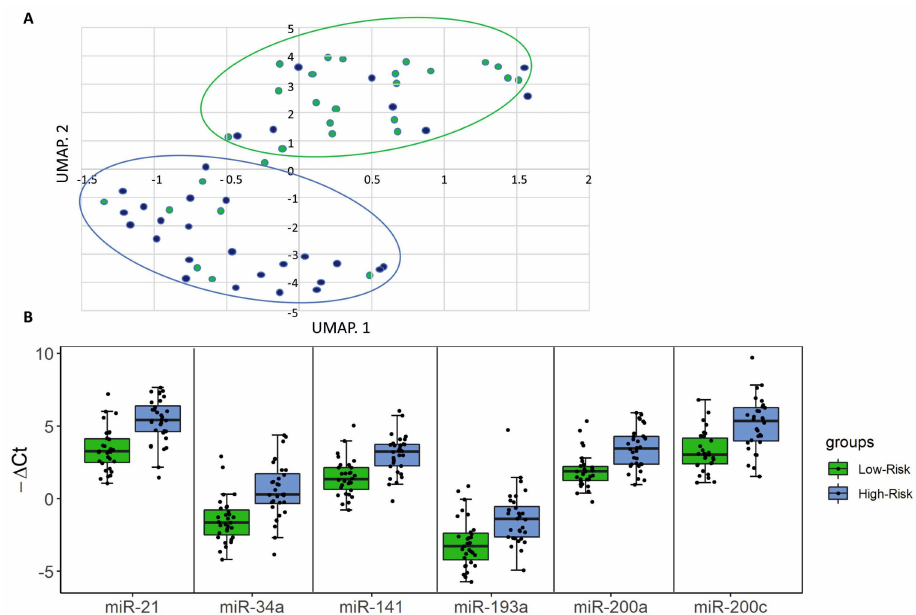
Figure 2. A urine cfmiRNA panel to discriminate high-risk from low-risk bladder cancer (BCa) patients. ( A ) Uniform Manifold Approximation and Projection (UMAP) analysis. Using a first cut-o ff of p < 0.05, we identified 10 miRNAs (miR-21, miR-22, miR-29a, miR-34a, miR-141, miR-193a, miR-200a, miR-200c, miR-205 and miR-532) and subjected them to UMAP analysis using − ∆ Ct x values. The UMAP plot shows that most of the high-risk patients (blue dots) and low-risk patients (green dots) segregated into distinct clusters. ( B ) Box plot analysis of 6 cfmiRNAs upregulated in high-risk BCa patients. With more stringent selection criteria of fold change (FC) > 2.5 and p < 0.005, we further restricted the analysis to a 6-cfmiRNA panel (miR-21, miR-34a, miR-141, miR-193a, miR-200a and miR-200c). The graphs show the − ∆ Ct distribution of these cfmiRNAs in low-risk (green) and high-risk (blue) patients. Dots represent individual patients. FCs and p value are indicated in Table